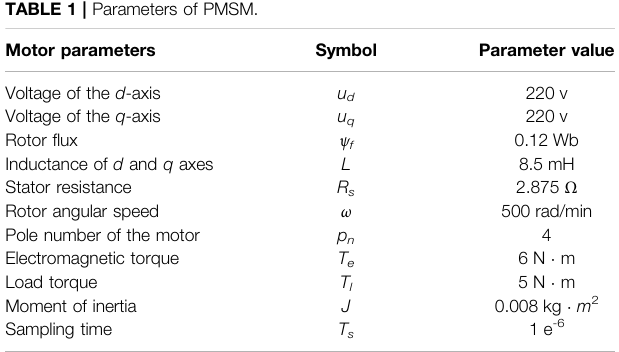
TABLE 1 | Parameters of PMSM.